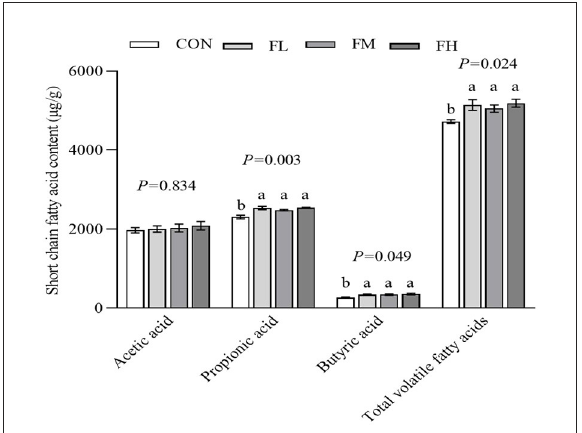
FIGURE6 The effects of fucoidan on cecum SCFA in weaned lambs. CON, control; FL, 0.1% fucoidan (DMI); FM, 0.3% fucoidan (DMI); FH, 0.6% fucoidan (DMI). Data are denoted as mean ± SEM ( n = 3). a,b Demonstrate a statistically significant distinction, P <